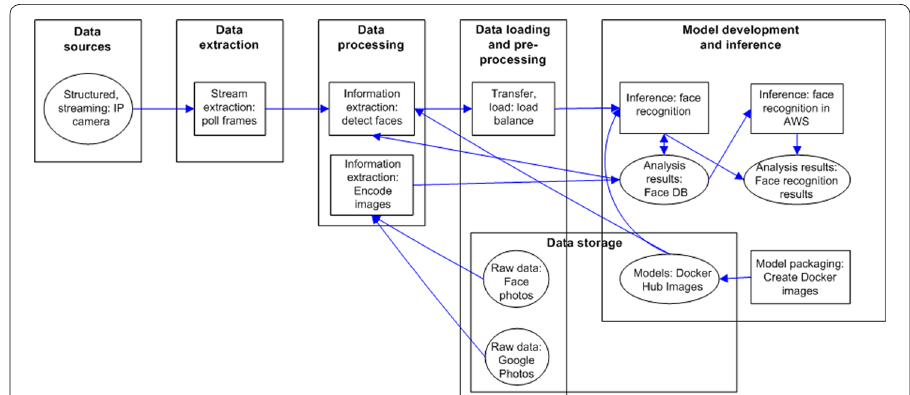
Fig. 13 The mapping of smart surveillance system on edge and cloud computing [45] to the big data RA